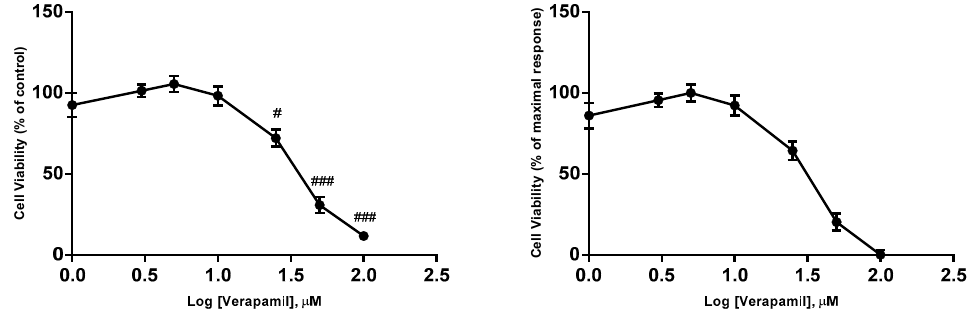
Figure 4. Concentration-effect curves obtained for verapamil. The drug was added in fresh medium, in sextaplicates. Results are presented as mean ± SEM of three independent experiments. The left curve represents the viability of cells (% of control), whereas the right curve represents a normalization between 0 and 1 (0% and 100%), where 100% was defined as the concentration of the drug that less affected the cell viability, and all other data points were normalized to this value, being 0% defined as the concentration that affected more the cell viability. ### p < 0.001 and # p < 0.05 vs. control.